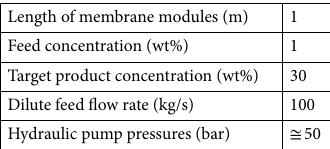
Table 5. Bases of the case study for the concentration of dilute aqueous sodium acetate.